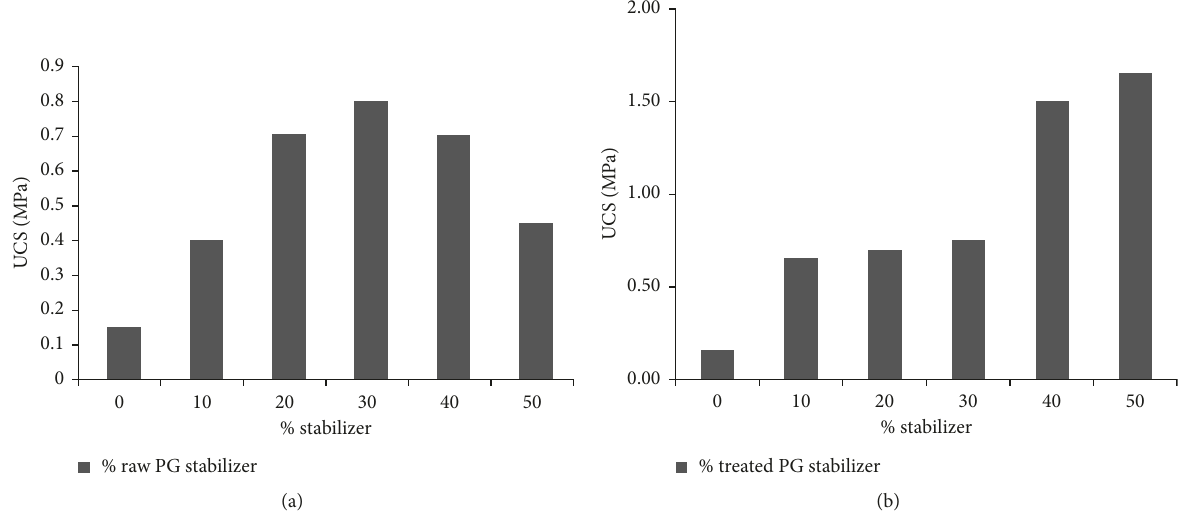
Figure 3: Stabilization of expansive soil with (a) raw PG and (b) treated